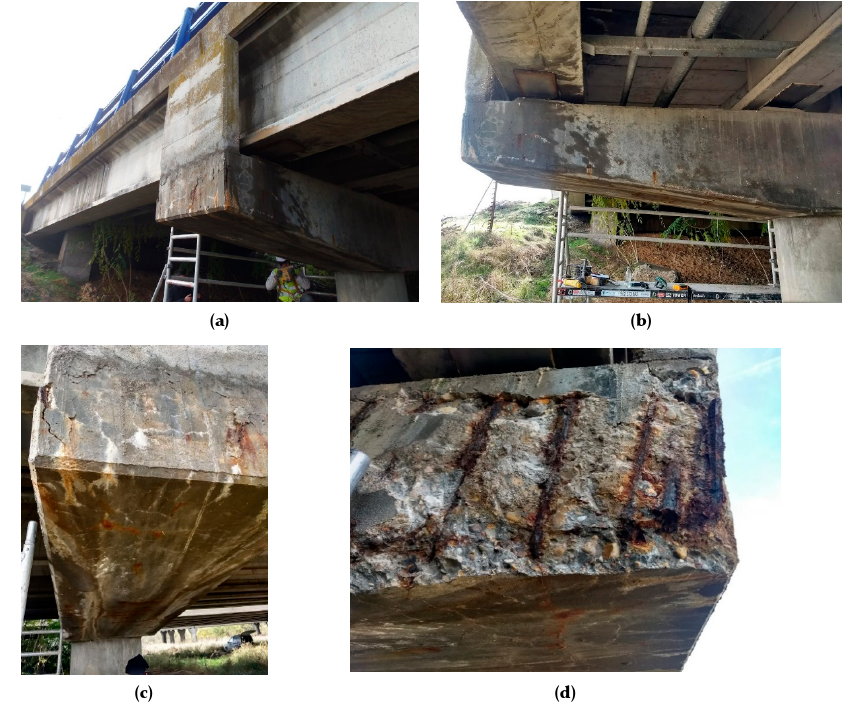
Figure 1. ( a , b ) Structure analysed from different perspectives; ( c , d ) Detailing (photos taken by S. Chinchón-Payá).